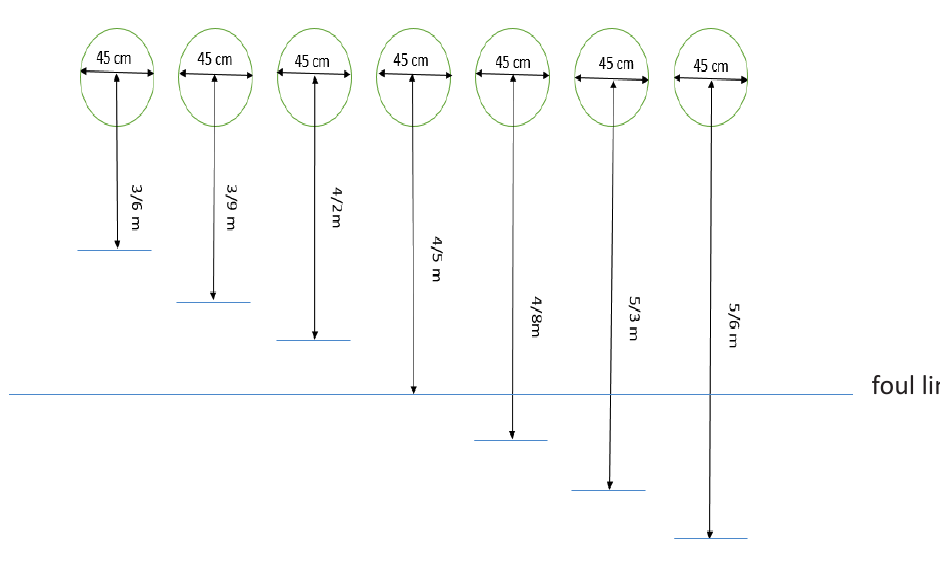
Figure 1: SHOTS from various distances toward the standard basket by subjects